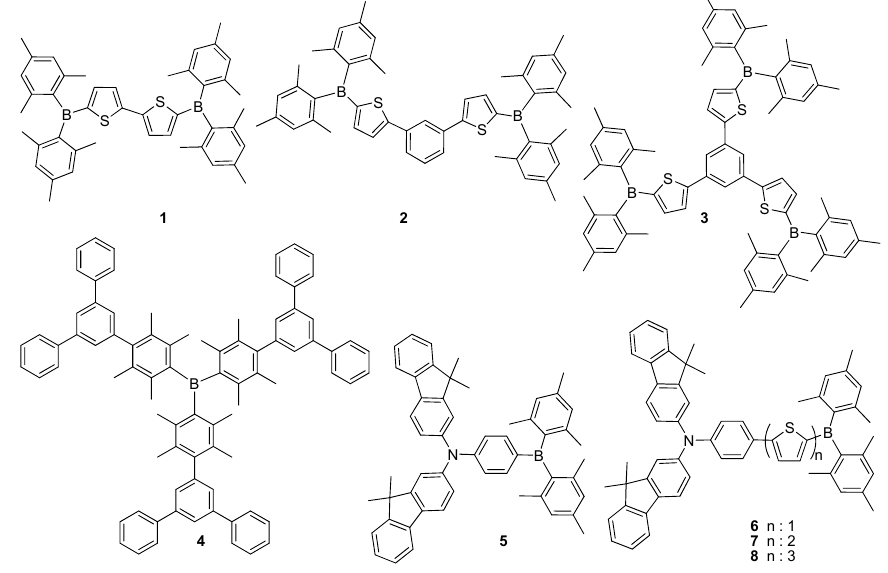
Figure 4. Chemical structures of conjugated D–A type materials 1 – 8 .